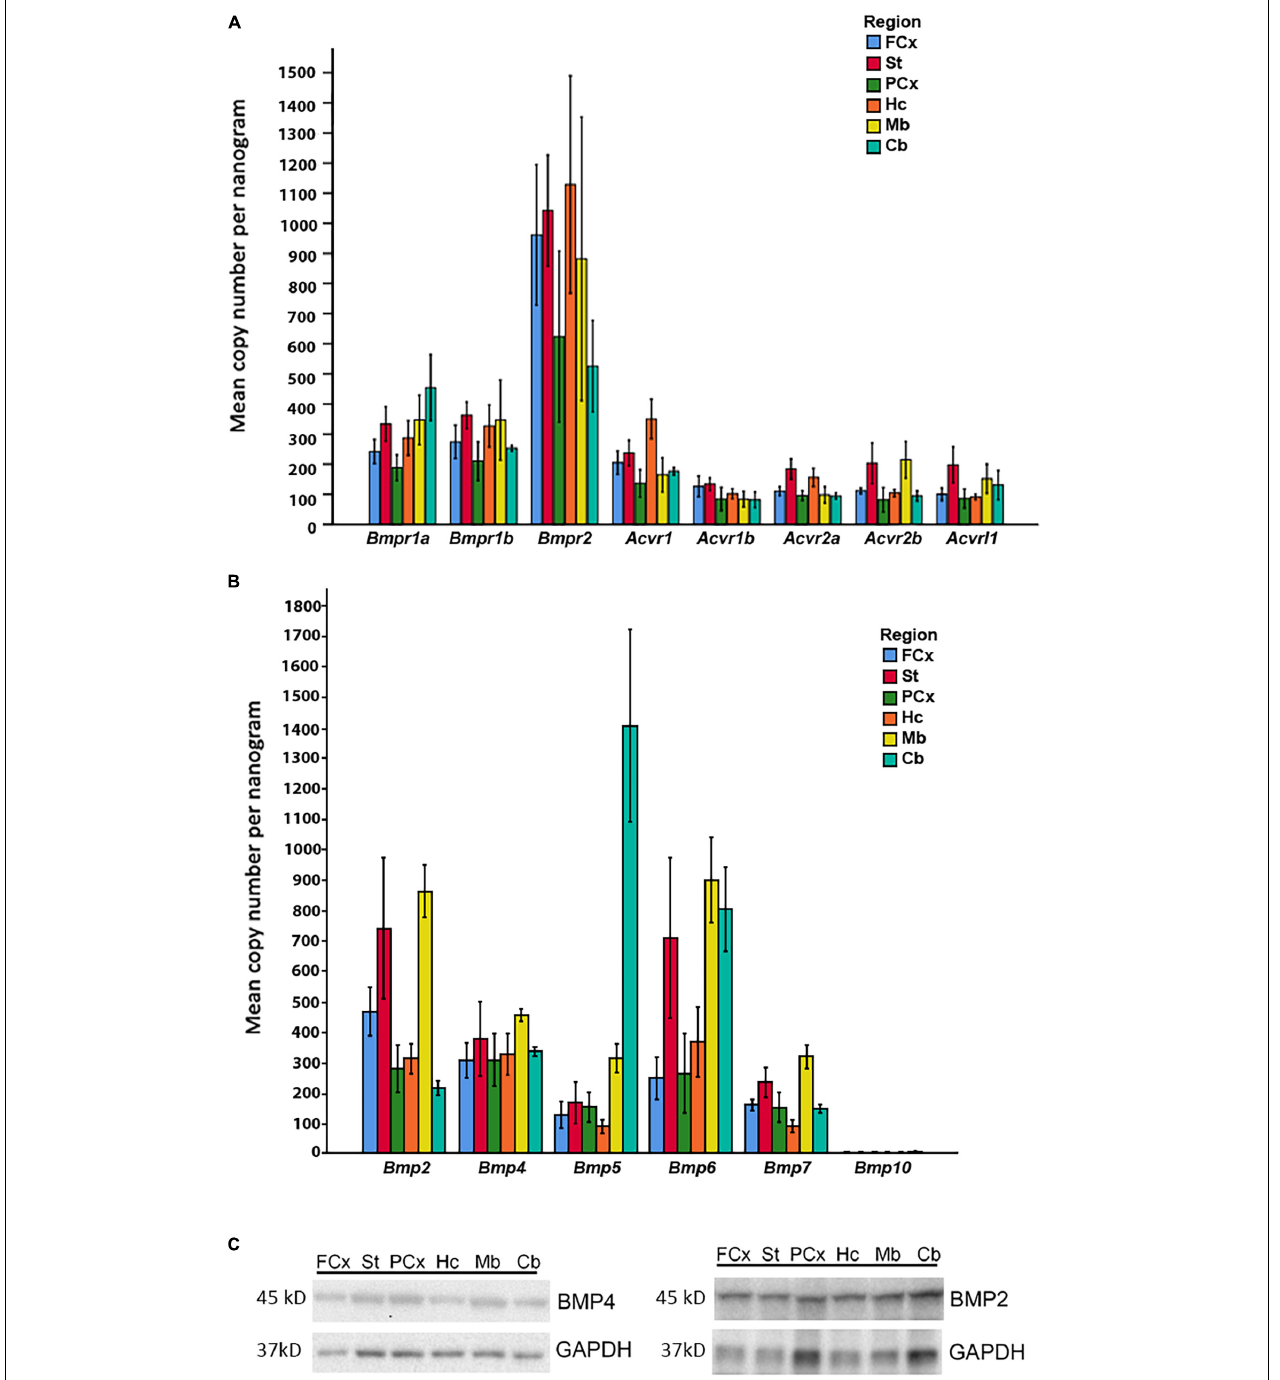
FIGURE 5 | Expression of BMP receptors and canonical BMPs in different brain regions. (A) RT-qPCR demonstrates expression of all Bmp receptor transcripts in different regions of adult mouse brain. Bmpr1a and Bmpr1b transcripts are moderately expressed, while Bmpr2 transcripts exhibit particularly high expression in all regions. Acvr1 , Acvr1b , Acvr2a , Acvr2b, and Acvrl1 transcripts all show low to moderate expression. Values presented as copy numbers per nanogram total RNA input into the cDNA reaction, Error bars = SEM; n = 4. (B) RT-qPCR demonstrates that all canonical BMPs, with the exception of Bmp10 , are expressed in all brain regions investigated. Bmp2 transcripts are expressed throughout the brain, with highest levels in striatum and midbrain. Bmp4 transcripts are moderately expressed throughout all regions. Bmp5 transcripts are moderately expressed throughout the brain, but highly expressed in cerebellum. Bmp6 transcripts are highly expressed in striatum, midbrain and cerebellum, while expression is moderate in other regions. Bmp7 transcripts are moderately expressed in all regions. Bmp10 transcripts were not detected in any of the investigated regions. Values presented as copy numbers per nanogram total RNA input into the cDNA reaction- Error bars = SEM; n = 4. (C) Representative immunoblot shows expression of BMP2 and BMP4 protein in the investigated brain regions in samples from the same animals, n = 4.